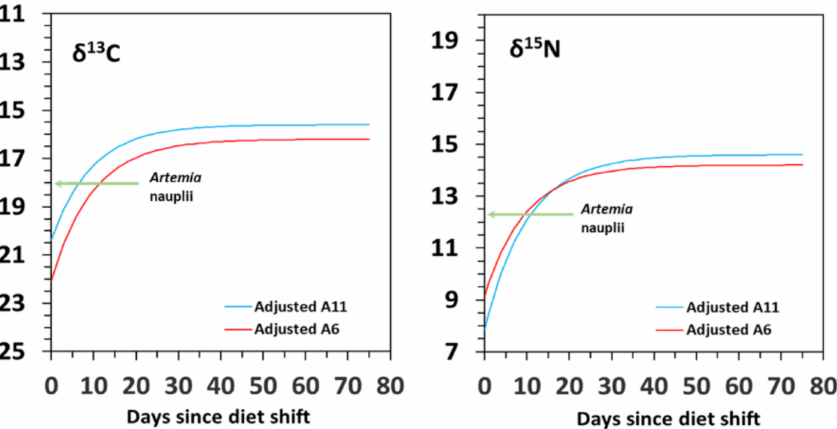
Figure 4. Model D–Relationships of changes in δ 13 C and δ 15 N (‰) as functions of the relative increase in days (since diet change) in seahorse Hippocampus reidi juveniles fed on diets A6 and A11. The curves refer to the feeding period on Artemia (11–60 DAR in diet A11; 6–60 DAR in diet A6). Diet: Artemia nauplii ( − 18.03‰ δ 13 C; 12.27‰ δ 15